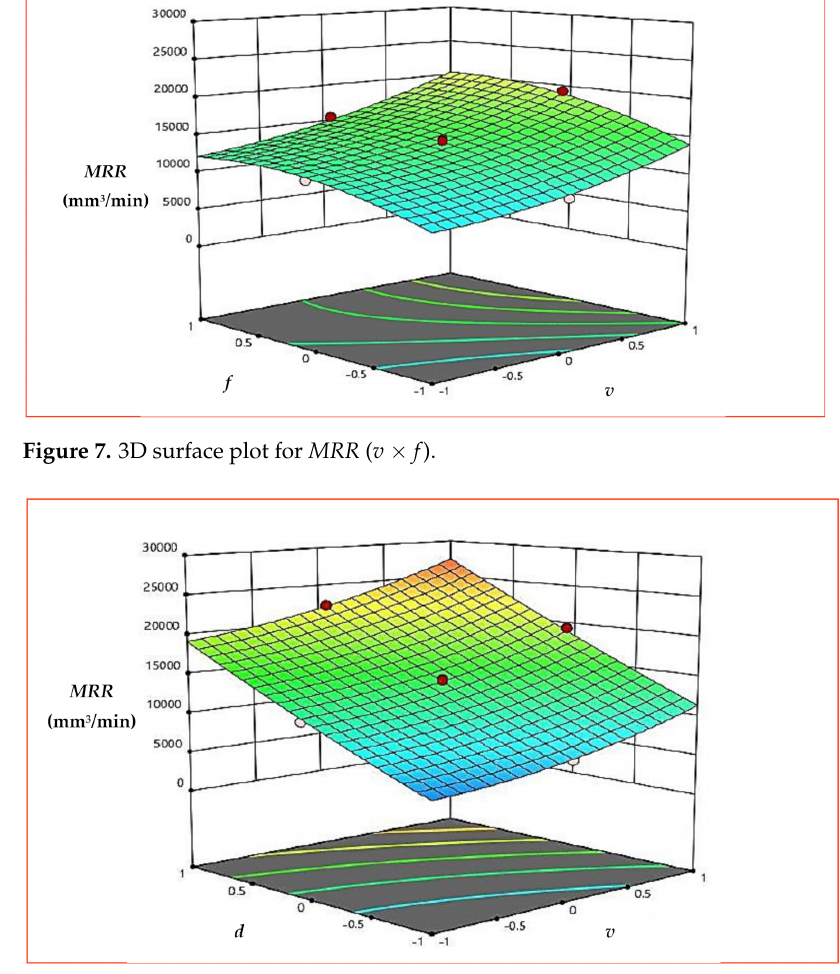
Figure 8. 3D surface plot for MRR ( v × d